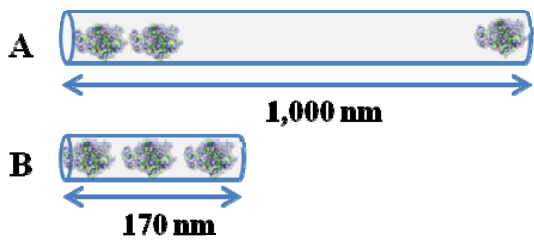
Figure 6. Schematic illustration of the laccase immobilization on SBA-15-L mesochannels ( A ) and SBA-15-S mesochannels ( B